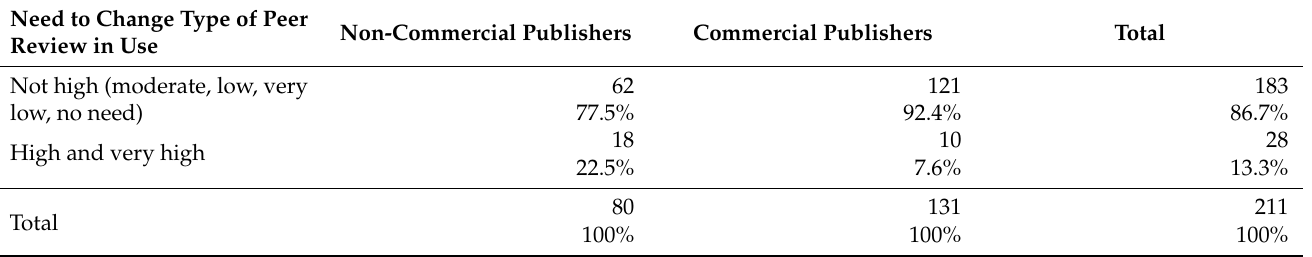
Table 7. Association between publisher’s commercial orientation and respondent’s estimation of need to change type of peer review in use.